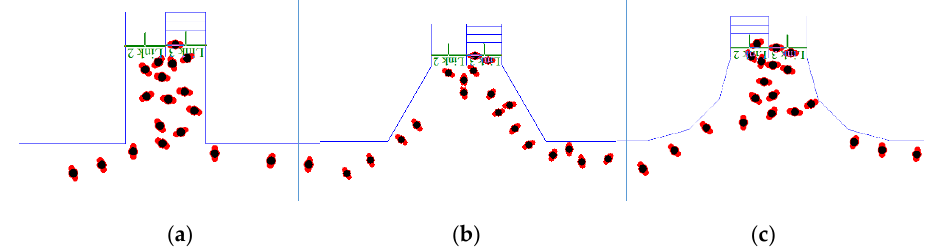
Figure 12. Right angle, cut (angle α : 15°, 30°, 45°), and rounded corner designs in the antechamber of the staircase.